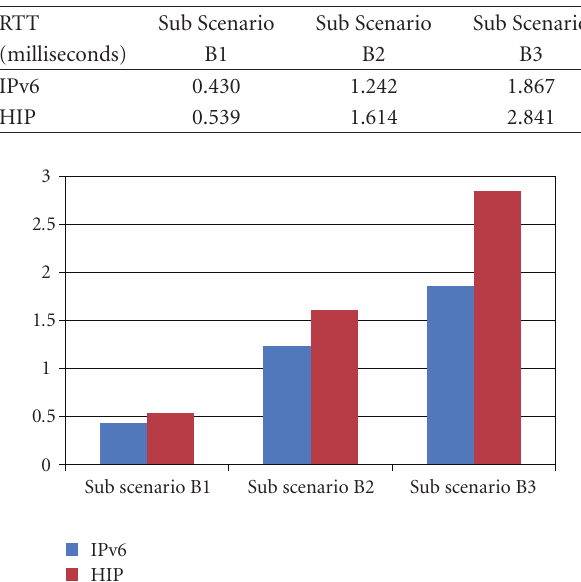
Table 6: Test Scenario B results-RTT measurements (milliseconds).